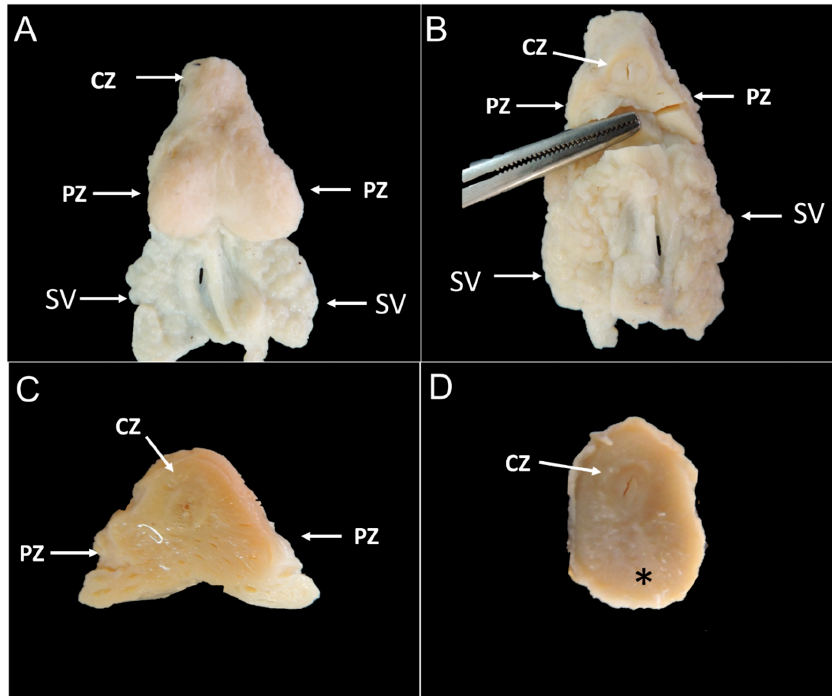
Figure 2. Gross image of adult ( A – C ) and young ( D ) giant anteater prostate glands. ( A ): it is possible to observe a bilobulated gland with a fibrous capsule. ( B ): transverse section showing a central zone surrounding the prostatic urethra and the two peripheral lobes (peripheral zones). ( C ): macroscopic appearance of the giant anteater prostate gland at transverse section, with the peripheral zones characterized by the presence of several cavities filled with a gelatinous material, (arrow) ( D ): transverse section showing a central prostatic urethra surrounded by a central zone and no clear definition of the peripheral zones (asterisk). CZ: central zone; PZ: peripheral zone; SV: seminal vesicle.